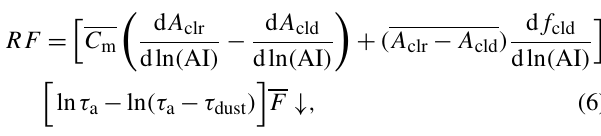
neighboring ocean, indicating larger particles (dust) reside